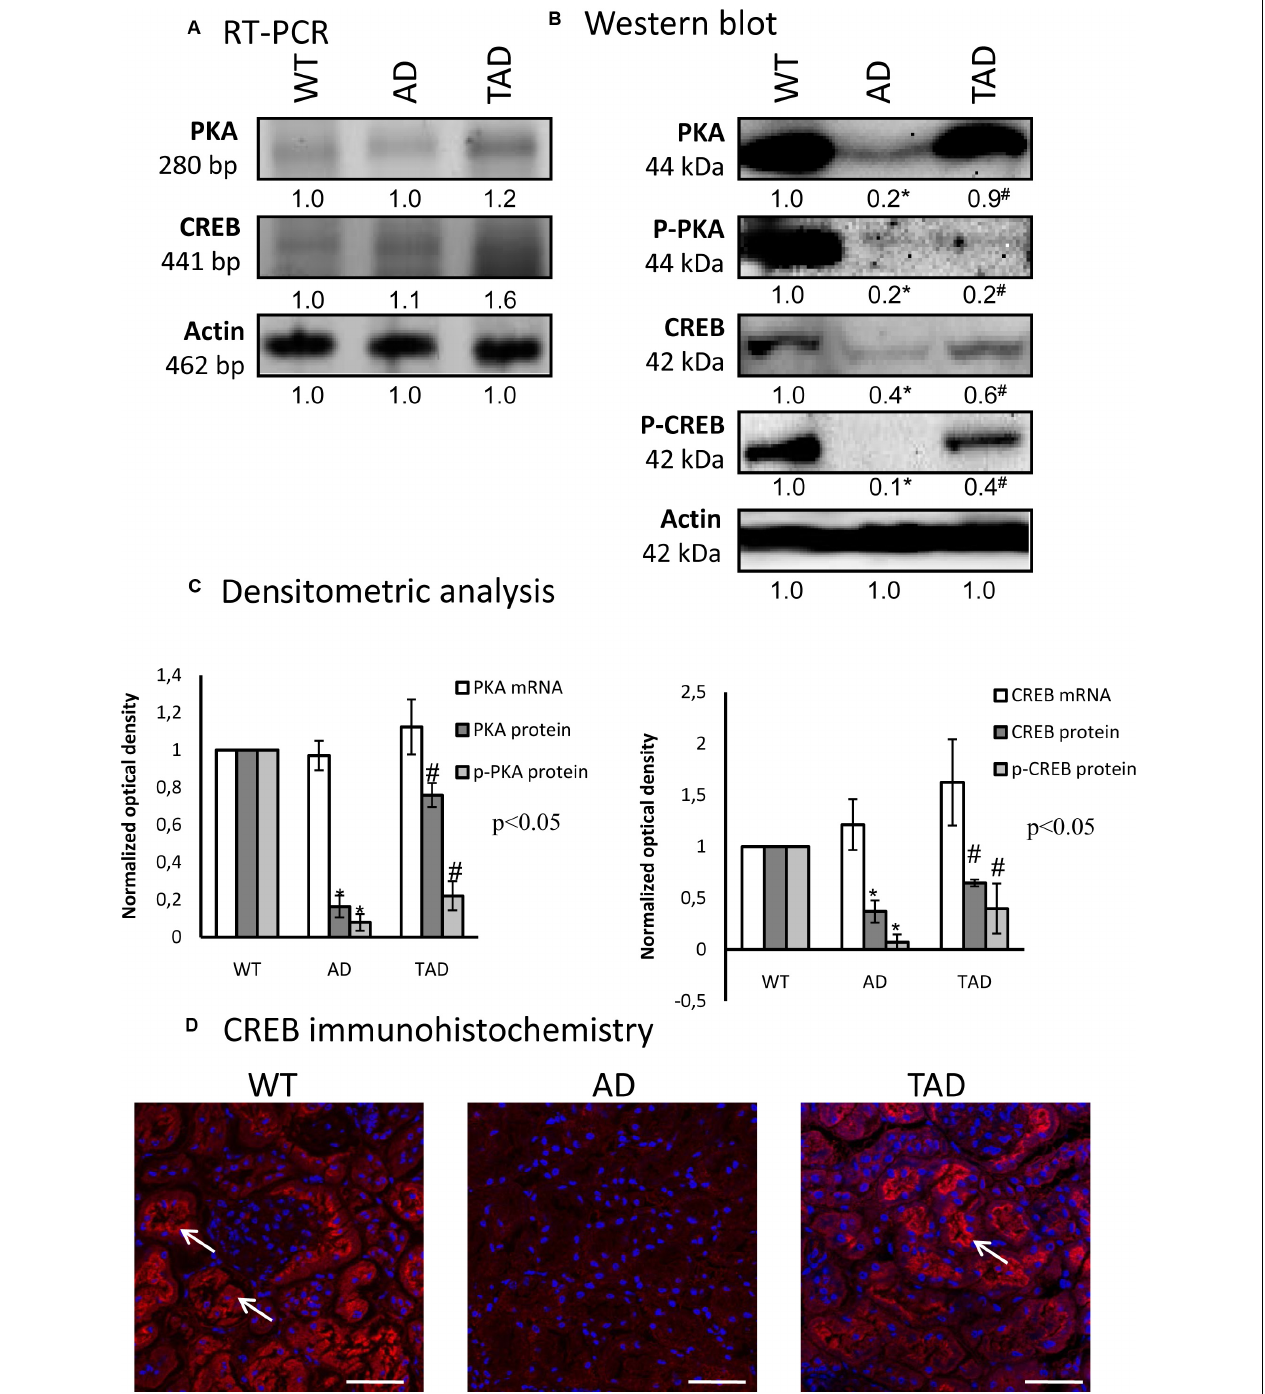
FIGURE 3 | mRNA (A) and protein (B) expressions of pituitary adenylate cyclase-activating polypeptide (PACAP) signaling in the kidneys. The optical density of the signals was measured and the results were normalized to the optical density of the controls. For (A,B) , the numbers below the signals represent the integrated densities of the signals determined by ImageJ software. Asterisks indicate significant ( ∗ p < 0.05) alterations of expressions as compared to the wild type (WT) and ( # p < 0.05) compared to Alzheimer’s disease (AD). Representative data of five independent experiments. For reverse transcription PCR (RT-PCR) and for Western blot, actin was used as the control. (C) Statistical analysis of the RT-PCR and Western blot data. All data presented are the averages of at least five different experiments. Statistical analysis was performed with Student’s t -test. All data were normalized on actin and are expressed as the mean ± SEM. (D) Immunohistochemistry of CREB in the cortex of the kidneys. Arrows show the apical part of the proximal tubules. Magnification was made with × 60 objective. Scale bar , 20 µ m.